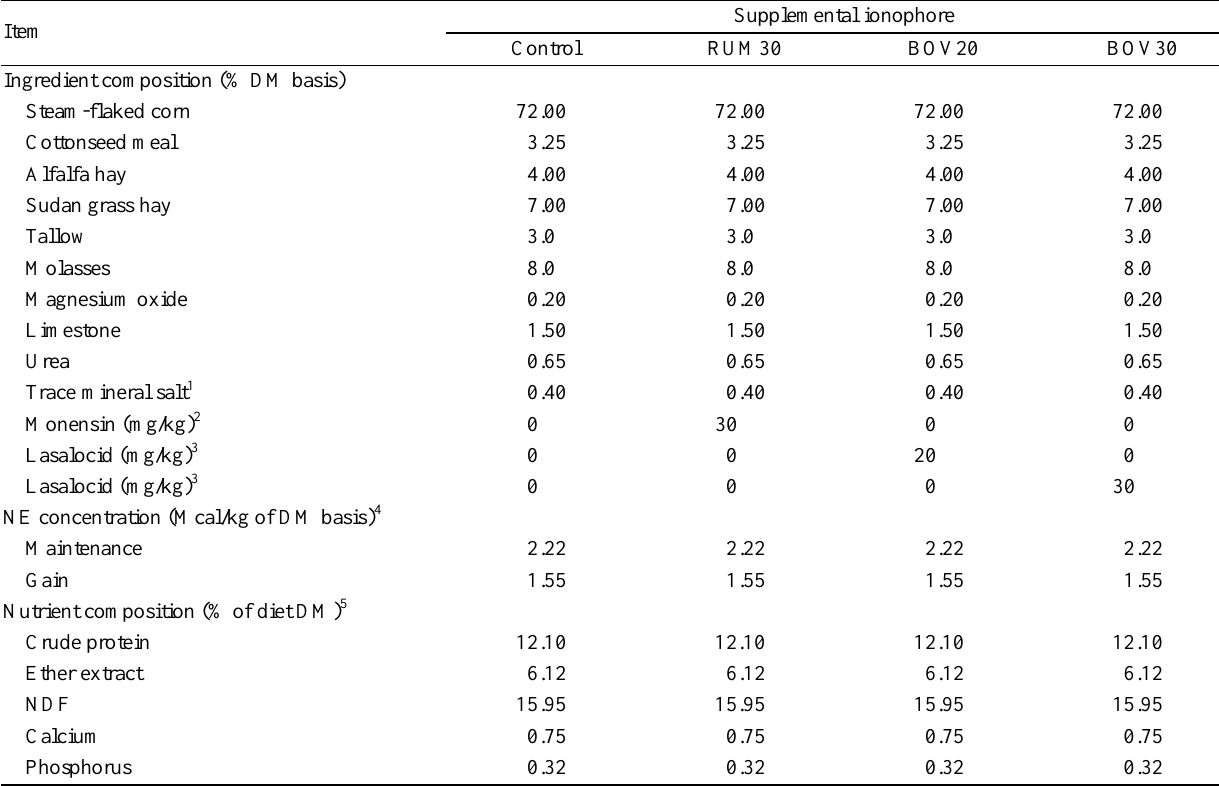
Table 1 . Ingredients and composition of diets fed to